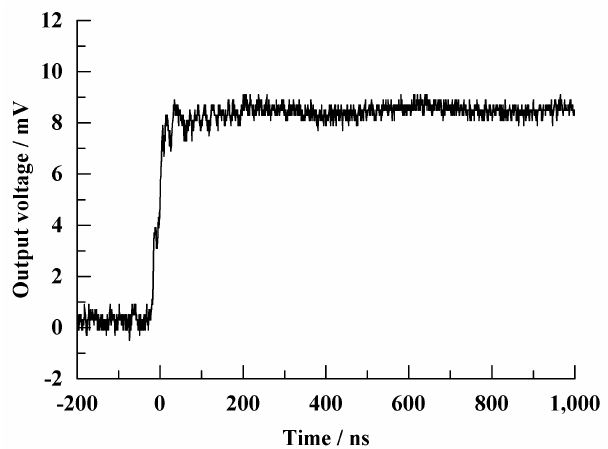
Figure 14. Step response waveform of the divider.